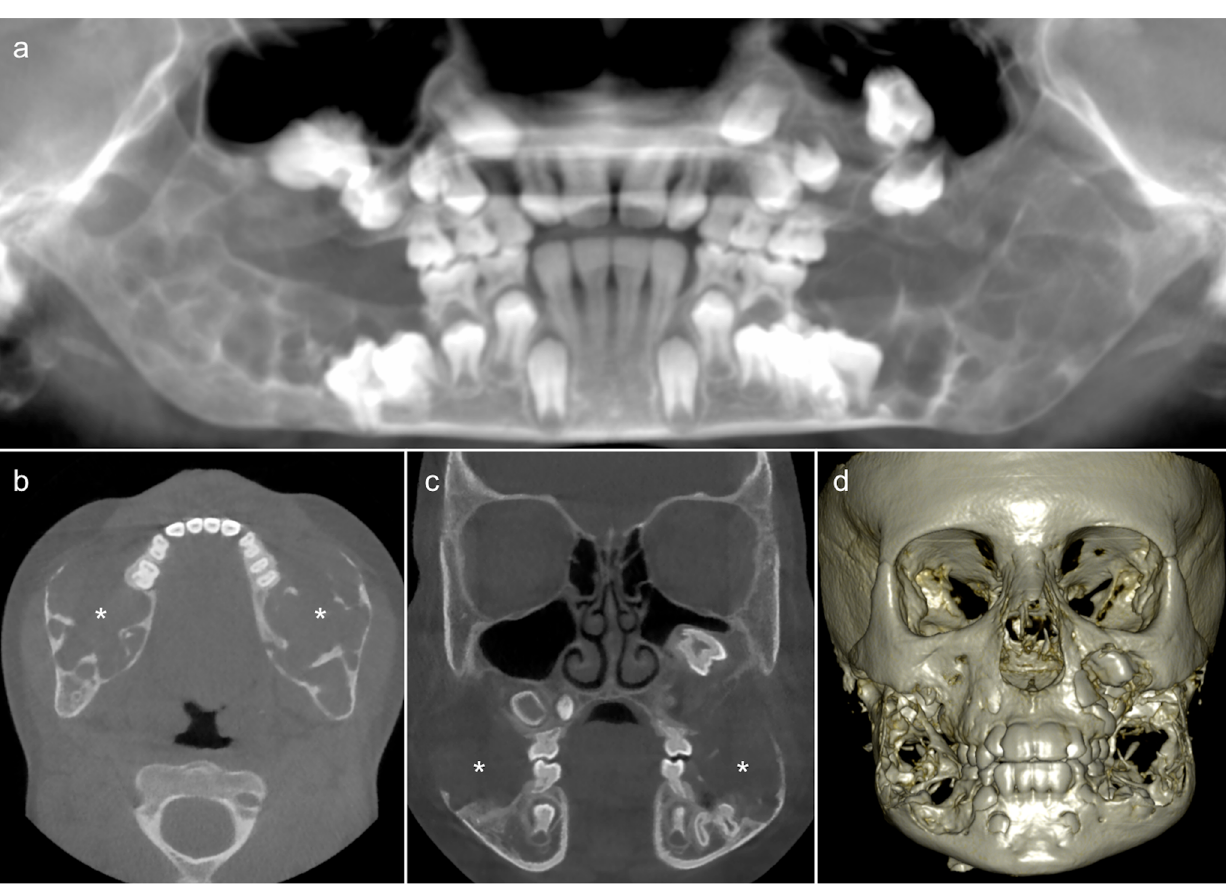
Fig. 3 An 8-year-old boy with progressive painless and symmetric bilat- eral facial enlargement. a Translucent cone beam CT (CBCT) thick-slab reconstruction shows well-defined bilateral multilocular radiolucencies with deformation and symmetric bilateral enlargement of the mandible and maxilla, and dental abnormalities (displaced permanent teeth and unerupted first molars). Axial ( b ) and coronal ( c ) CBCT images show